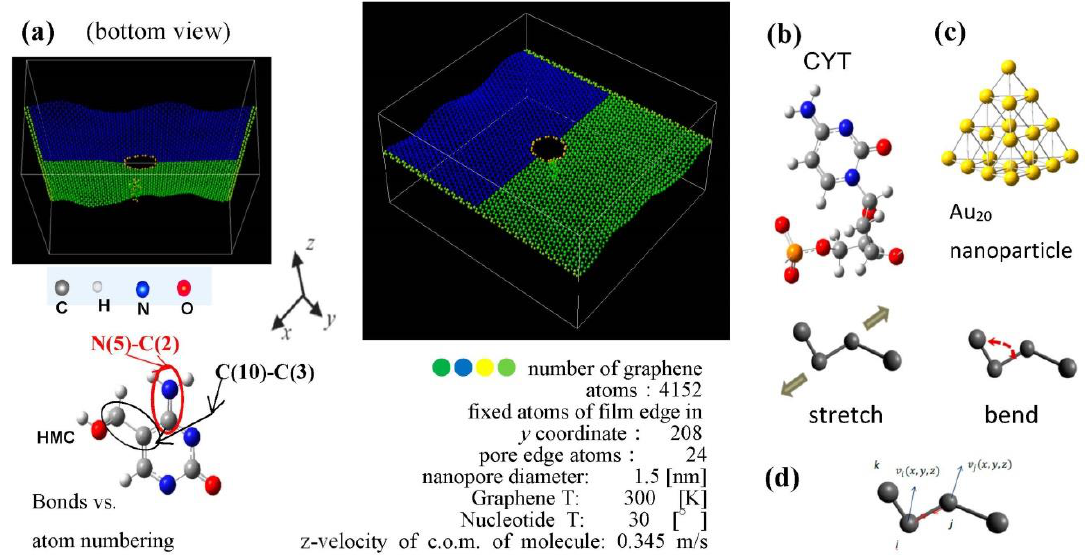
Figure 2. ( a ) The structure and initial position of cytosine nucleotide relative to the graphene pore. The spatial orientation of the nucleotide’s cyclic plane is at 30 ◦ to the z-x plane. Atoms are shown: C in grey, N in blue, O in red, and H in light grey. ( b ) Initial configuration of cytosine (right). Hydroxymethylcytosine (HMC) base is shown on the left as an example of corresponding atom numbering for bonds in molecular dynamic (MD) calculations. ( c ) Optimized by density functional theory with generalized gradient approximation (DFT GGA) calculations Au 20 nanoparticle. ( d ) Reaction coordinates for stretching and bending in velocity correlation calculation use the 𝑣⃗ pro- jections along the bonds.